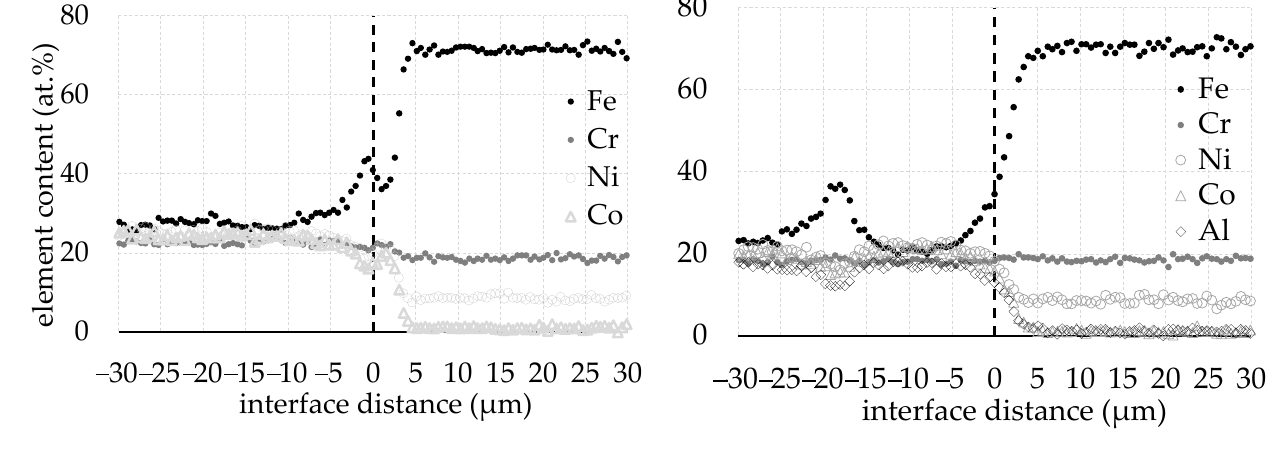
Figure 2. EDS elemental mapping within the transition area between HS-LMD coating and substrate material. ( a ) CrFeCoNi coating, ( b ) AlCrFeCoNi coating.